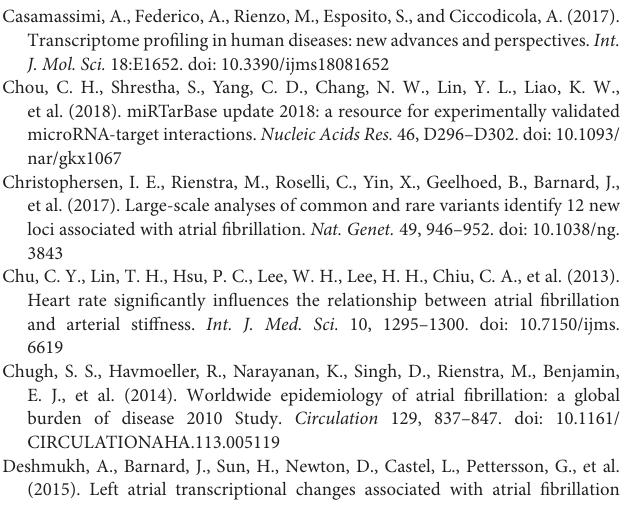
TABLE S2 | The potential ceRNA network merged with the PPI network of circRNAs. TABLE S3 | The KEGG pathways involving 102